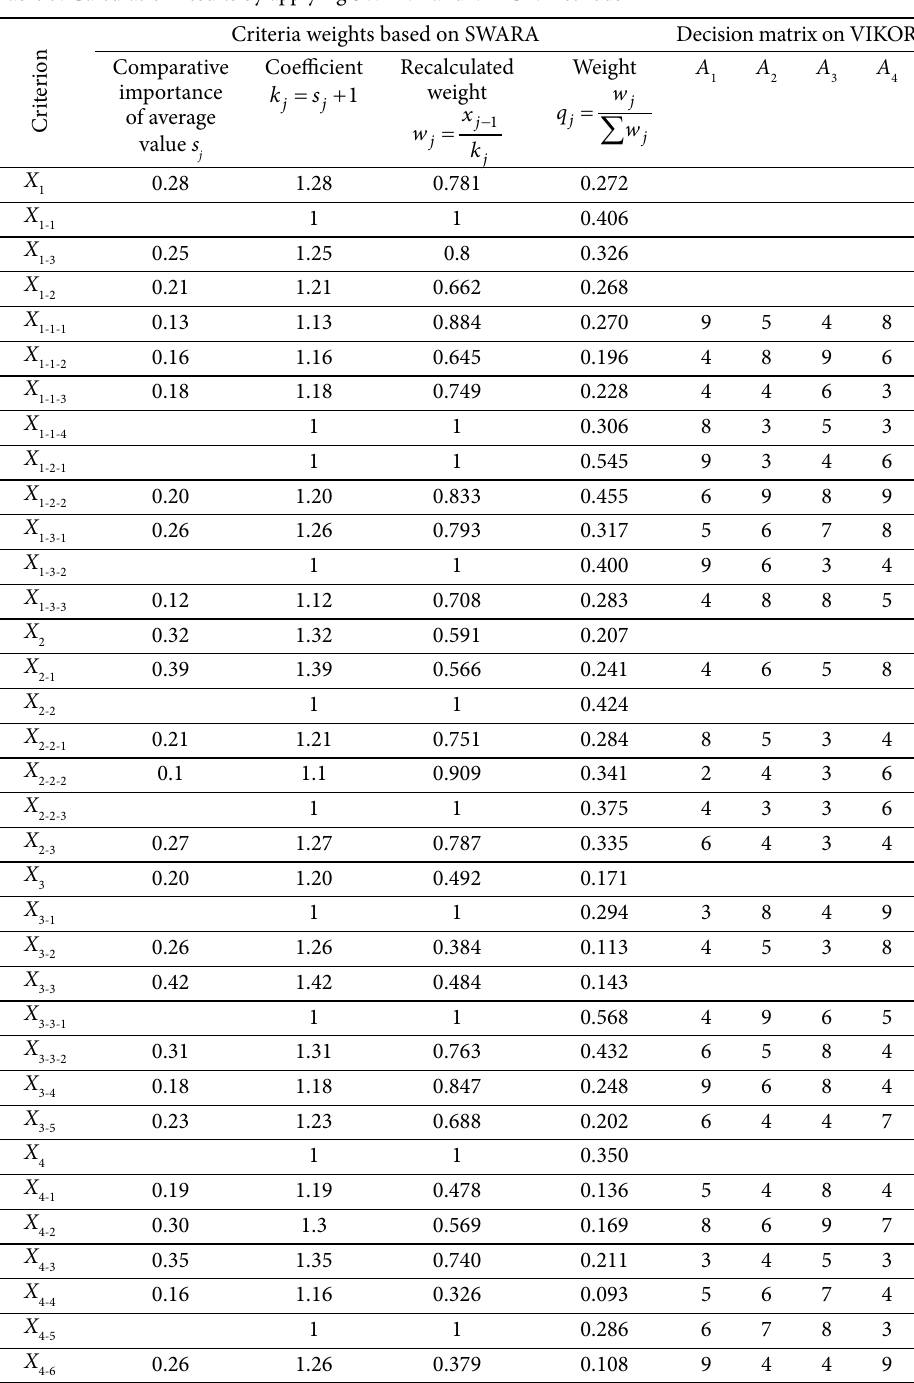
Table 3. Calculation results by applying SWArA and Vikor